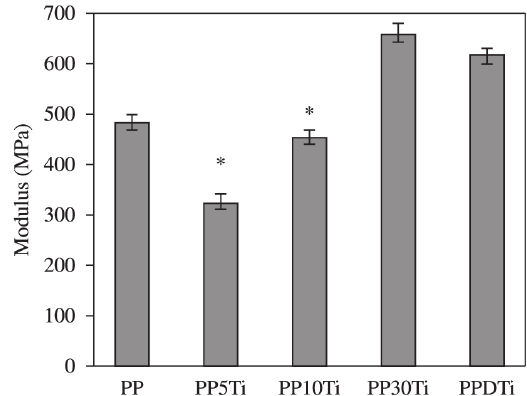
Figure 7. Young’s modulus of the PP Nano-composite. *significantly different from pure P, (Unpaired Student’s t test, P < 0.05).